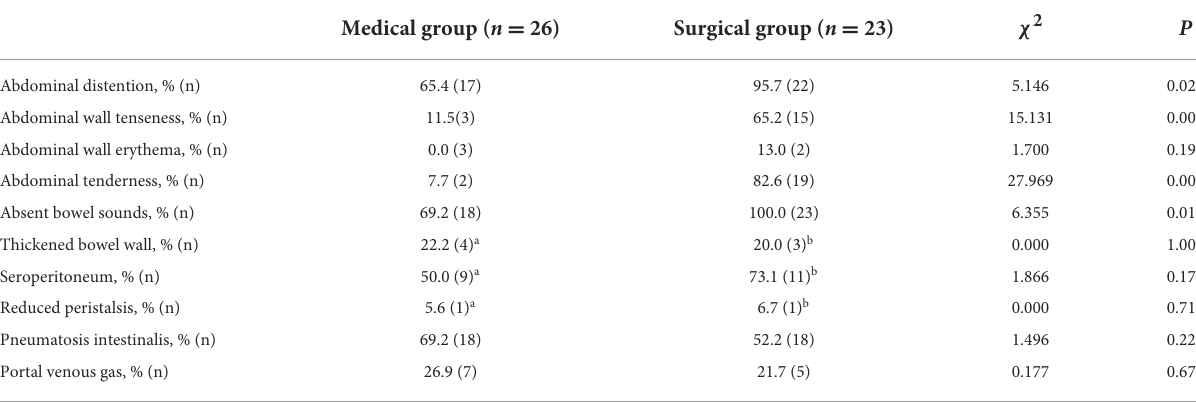
TABLE 2 Abdominal signs and imaging results of the infants in the two groups. Medical group ( n = 26) Surgical group ( n = 23)